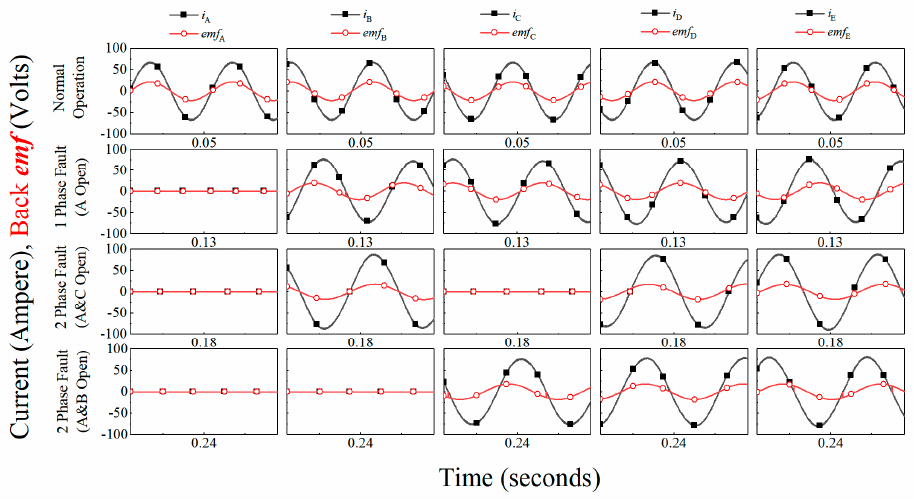
Figure 12. Current and back-emf profiles in the case of healthy operation and one- and two-phase fault operations.